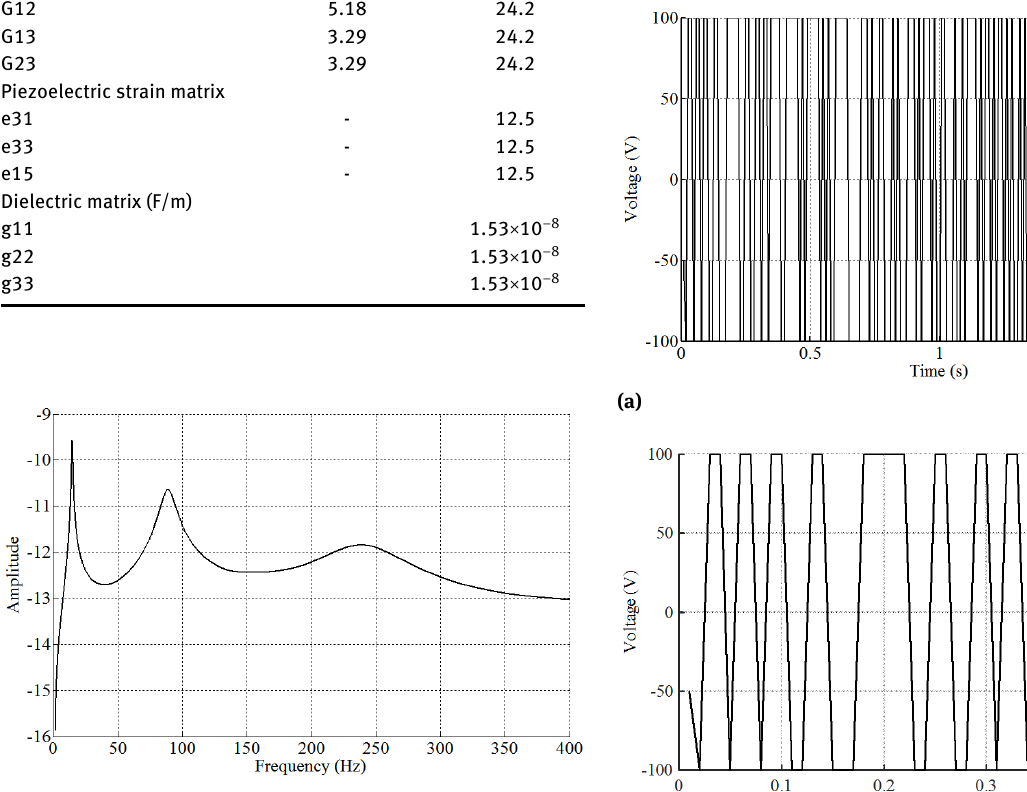
To obtain the state space equation, the model is sub- jected to a random chirp voltage with repeatable value